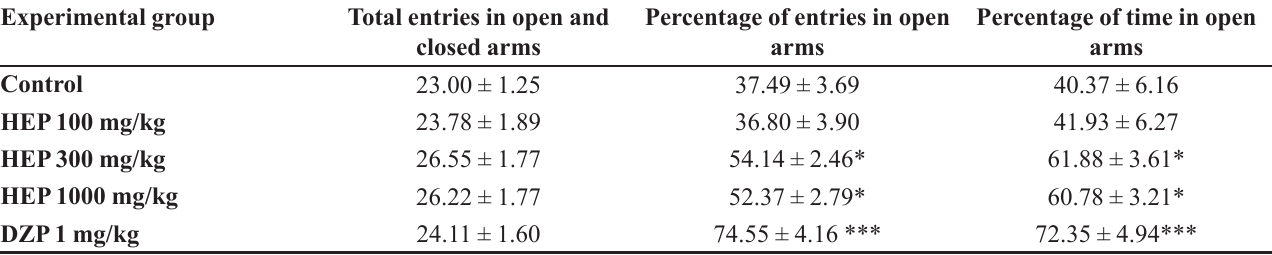
Data expressed as mean ± SEM of nine mice. Control: vehicle (saline, 10 mL/kg, p.o.), HEP: Hydroalcoholic extract from